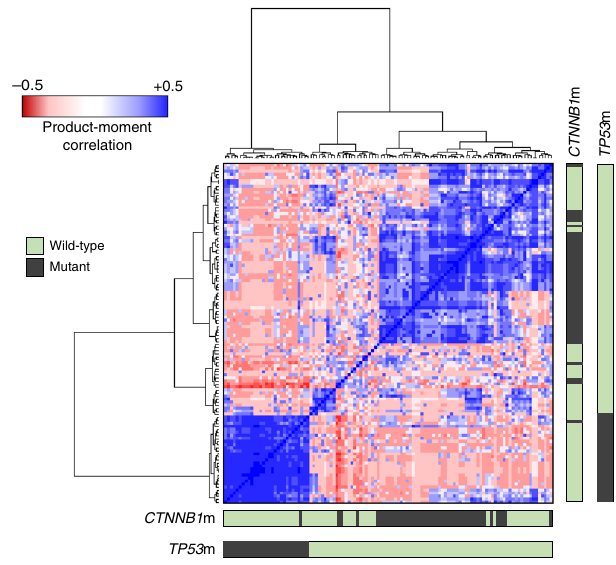
Fig. 2 Unsupervised clustering of endometrioid ovarian carcinomas by patterns of mutation. Product-moment correlation scores between samples were calculated using binary matrices representing the status of most frequently mutated genes (1 = mutant, 0 = wild-type), yielding a matrix of quanti fi ed genomic correlation. These data were subject to hierarchical clustering using Euclidean distance and Ward ’ s linkage. Bars denote mutation in CTNNB1 and TP53